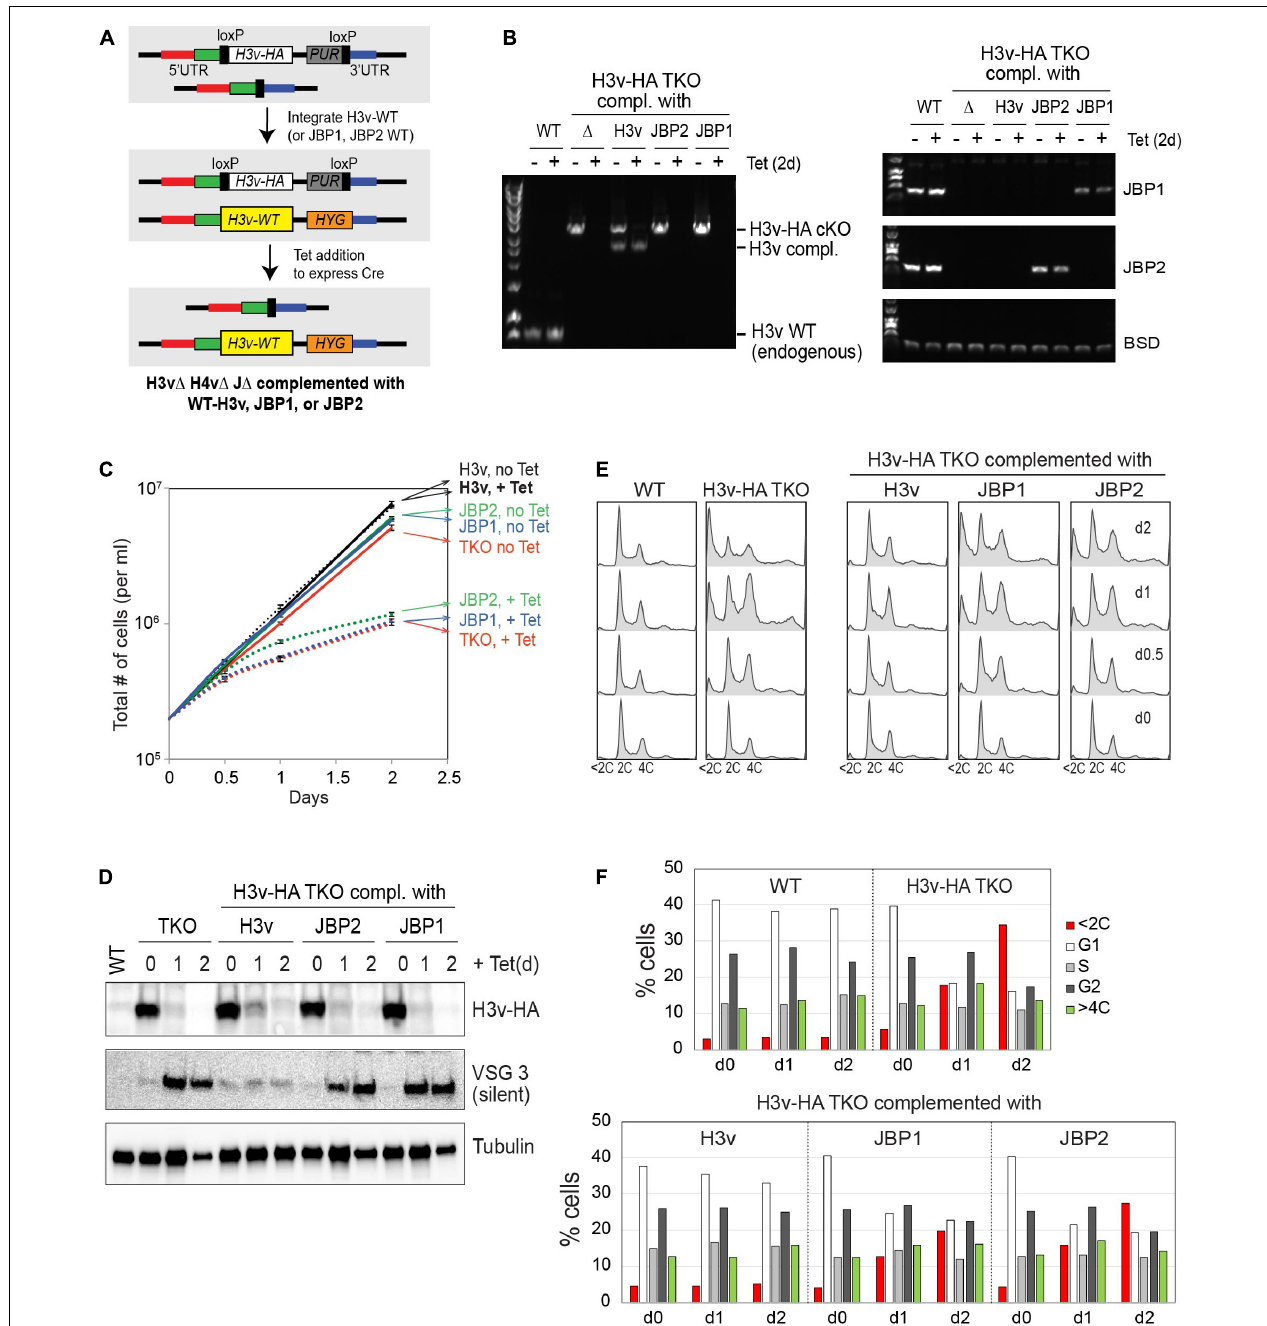
FIGURE 8 | Full and partial complementation of TKO phenotypes by H3v and JBP1/2. (A) A strategy to generate complemented cell lines. WT-H3v, JBP1, or JBP2 gene was reintroduced to the H3v-HA TKO strain (floxed H3v-HA in H4v (cid:49) J (cid:49) strain) at the endogenous H3v locus where the H3v was deleted and the selection marker removed. Because the targeting vectors do not have loxP sites, Cre cannot remove the complementing gene, while it removes floxed H3v-HA allele. Resulting cells will express WT-H3v, JBP1, or JBP2 in H3v (cid:49) H4v (cid:49) J (cid:49) background. (B) PCR genotyping confirming the removal of the floxed H3v-HA allele and the presence of complemented H3v, JBP1, or JBP2 gene in Tet-untreated or Tet-treated TKO strains. (C) Complementation of growth defect. TKO or TKO strain integrated with WT-H3v, JBP1, or JBP2 was treated with tetracycline for 0, 0.5, 1, and 2 days as the cell count was monitored. (D) Complementation of silent VSG3 derepression. H3v-HA and VSG3 protein expression by western blot. (E) Complementation of cell-cycle defect. Cells treated as in (C) were fixed and stained with PI and analyzed by flow cytometry. (F) Graphs showing percentage of G1, G2, S, and cells with abnormal DNA content (e.g., < 2C or > 4C).